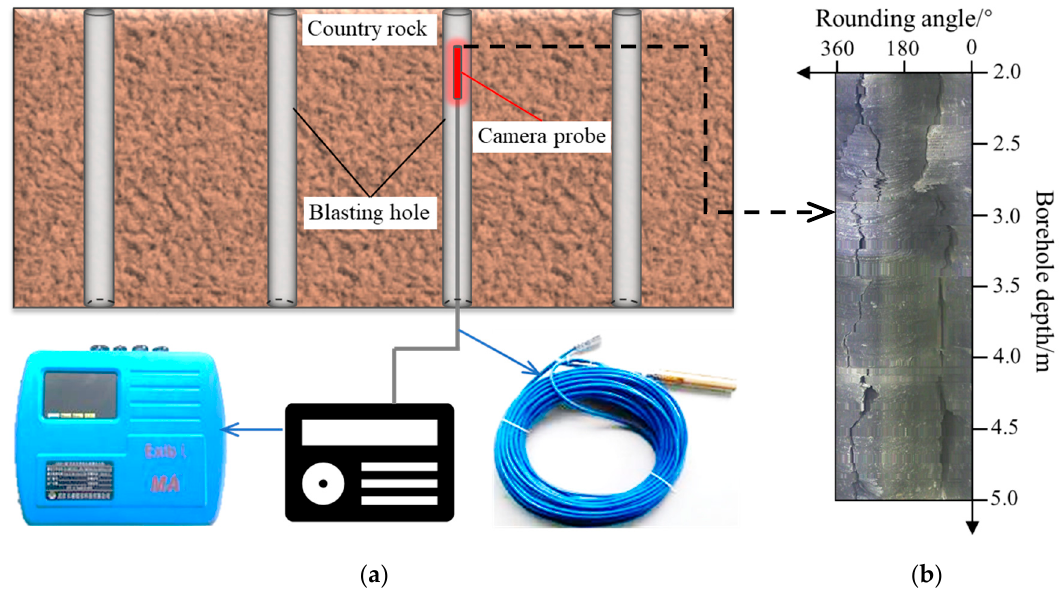
Figure 10. Borehole peeping. ( a ) Mining panel layout; ( b ) stratigraphic column of the 6302 mining panel.